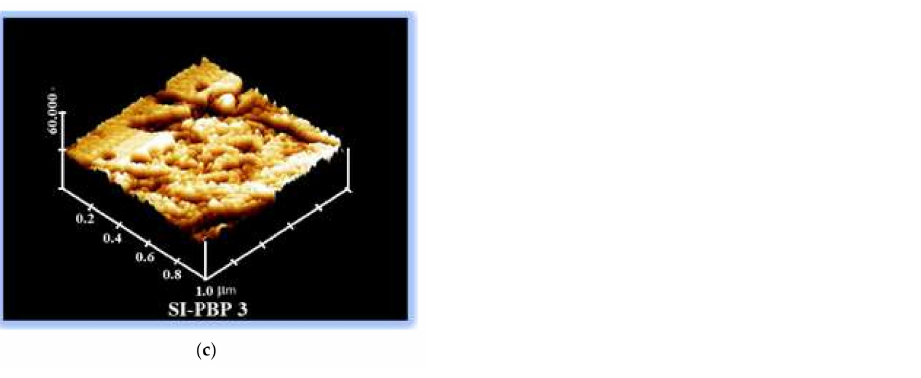
Figure 7. Atomic force microscopy images for ( a ) SI-PBP 1, ( b ) SI-PBP 2 and ( c ) SI-PBP 3 poly- mer membranes.